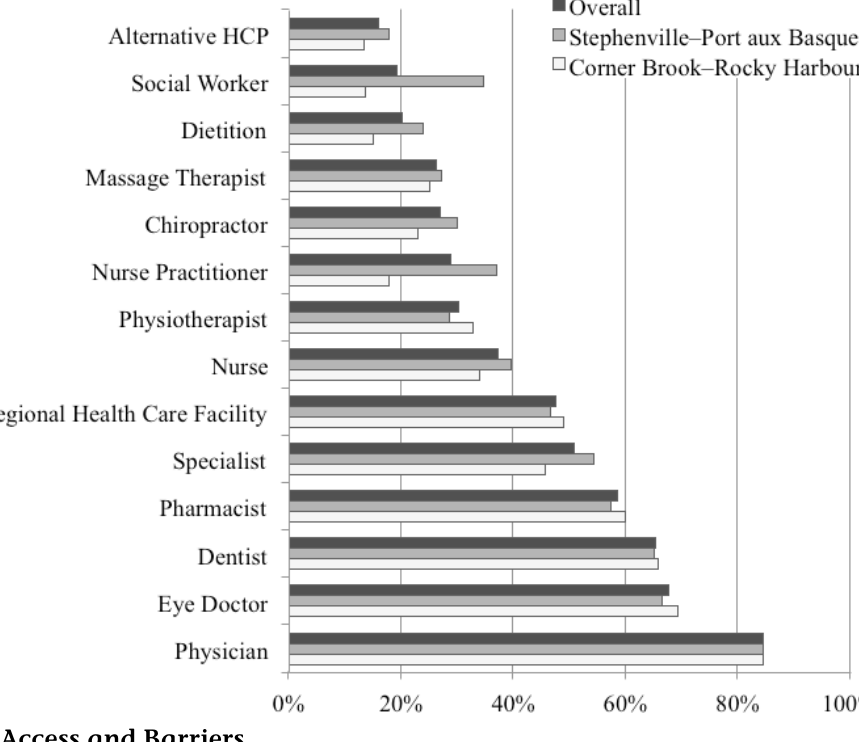
Figure 3: Health providers that respondents